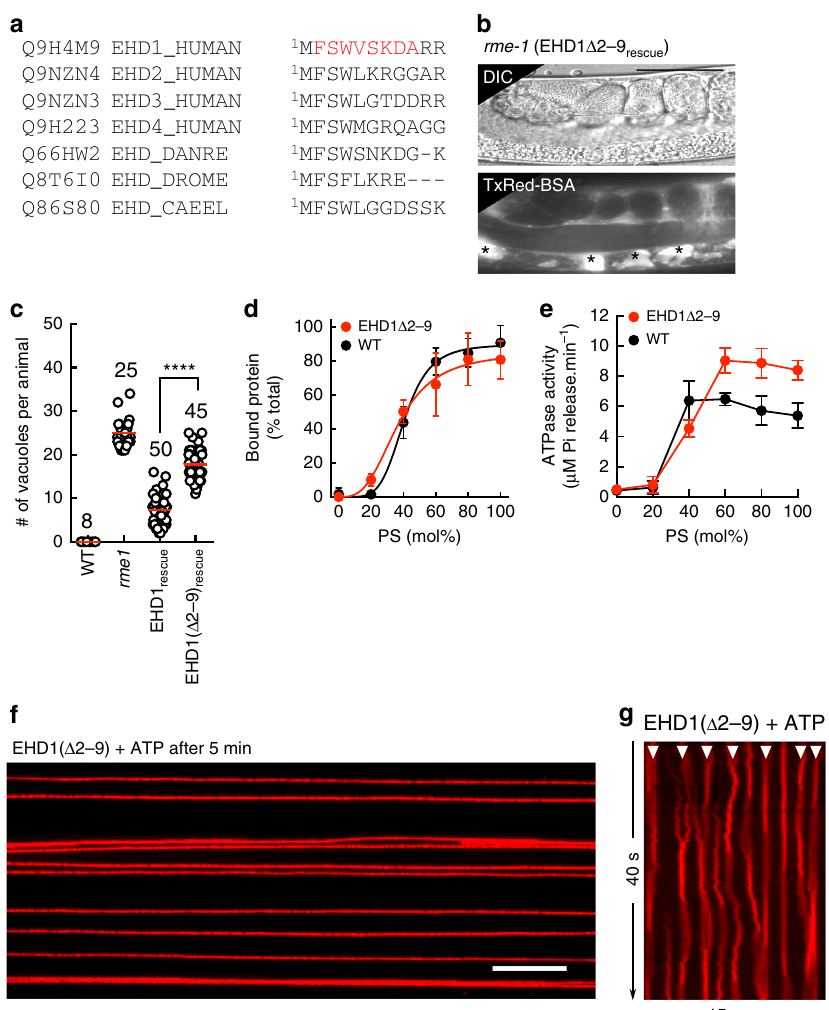
Fig. 9 N-terminal residues are critical for EHD1 function. a Alignment of the N-terminal region in EHD proteins. b Representative DIC and fl uorescence images of worms injected with fl uorescent BSA. Asterisks mark vacuoles. Scale bar = 50 μ m. c Plot showing vacuole numbers per worm for the indicated numbers of worms. Red line denotes mean. Data for WT, rme-1 and EHD1 rescue are shown for comparison. Statistical signi fi cance was assessed using an unpaired two-tailed t -test and **** P < 0.0001. d Bound fraction of EHD1( Δ 2 – 9) with liposomes of increasing PS content (mean ± SD, n = 3). Data for WT is shown for comparison. e ATPase activity of EHD1( Δ 2 – 9) with liposomes of increasing PS content (mean ± SD, n = 3). Data for WT is shown for comparison. f Representative micrograph showing EHD1( Δ 2 – 9) added to templates with ATP after 5 min (see Supplementary Movie 6). Scale bar = 10 μ m. g Representative kymograph of tube images acquired in the membrane fl uorescence channel showing the formation and dissolution of membrane bulges (white